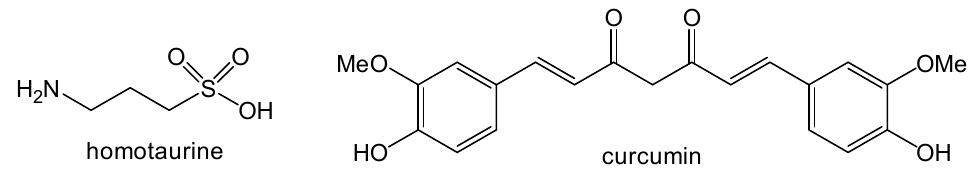
Figure 1. Chemical structures of homotaurine and